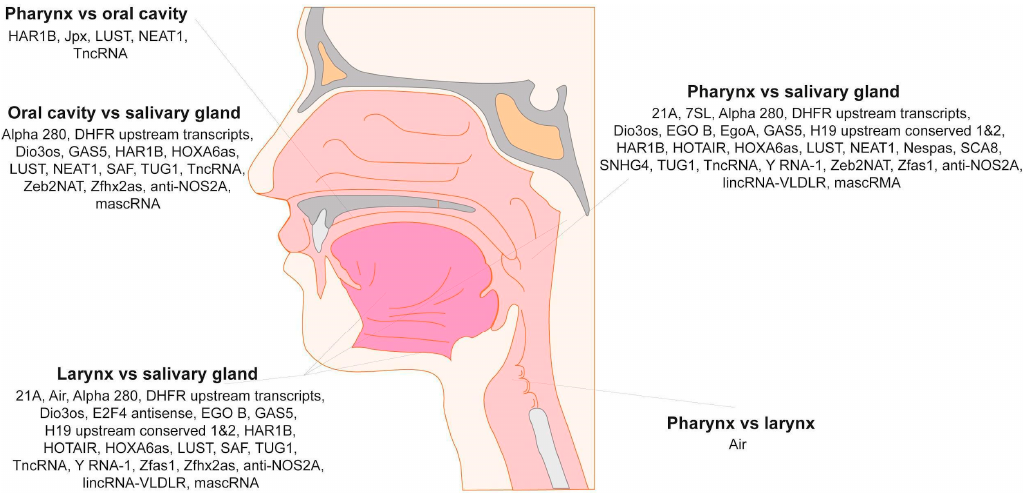
Figure 4. Changes in plasma lncRNA expression in HNSCC patients depending on the tumor localization in the pharynx, oral cavity, larynx and salivary gland sites. Only statistically significant changes ( p < 0.05) in lncRNAs between groups are presented.